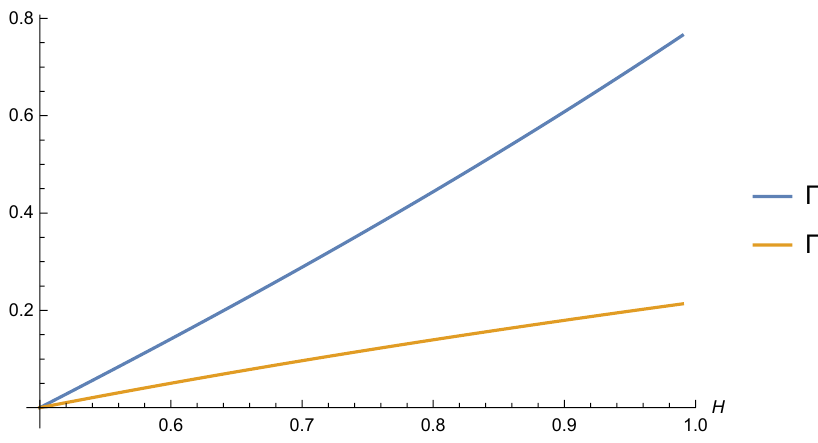
Figure 1. Case n = 3: Γ 2